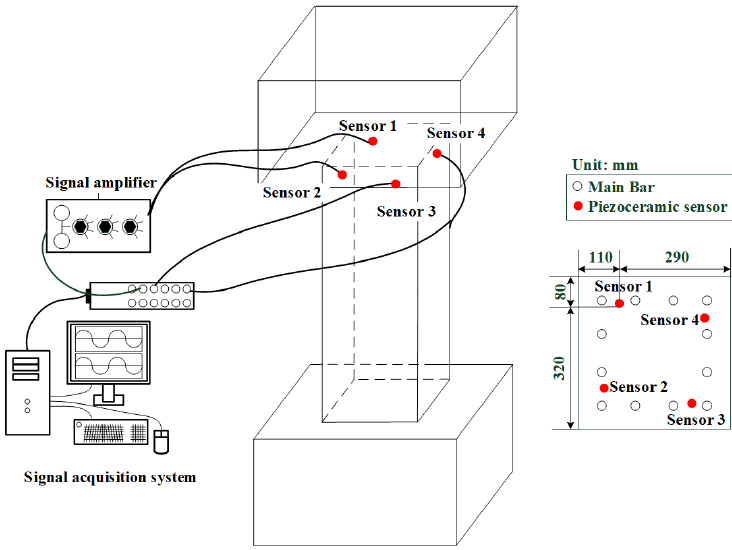
Figure 5. Locations of sensors and configuration of specimen (unit: cm).